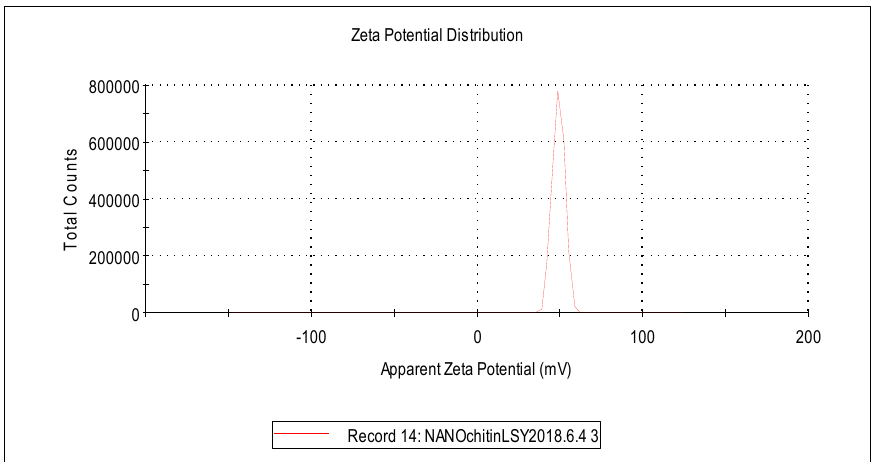
Figure 2. The zeta potential of nanochitin particles in DI water, which was determined by DLS. The value of the zeta potential of the nanochitin was +49.4 mV.